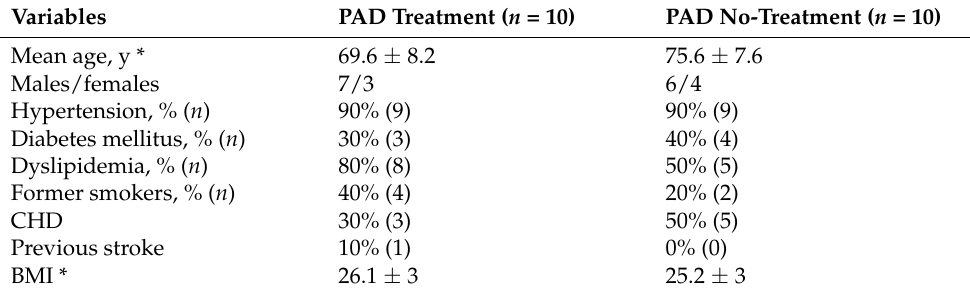
Table 2. Clinical characteristics of PAD